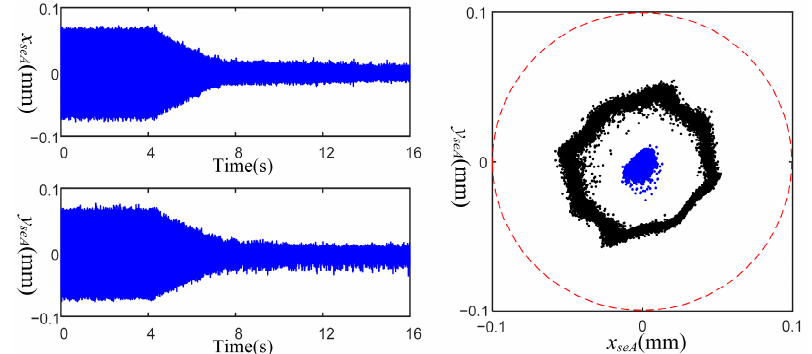
Figure 11. Experimental results of displacement vibration elimination.